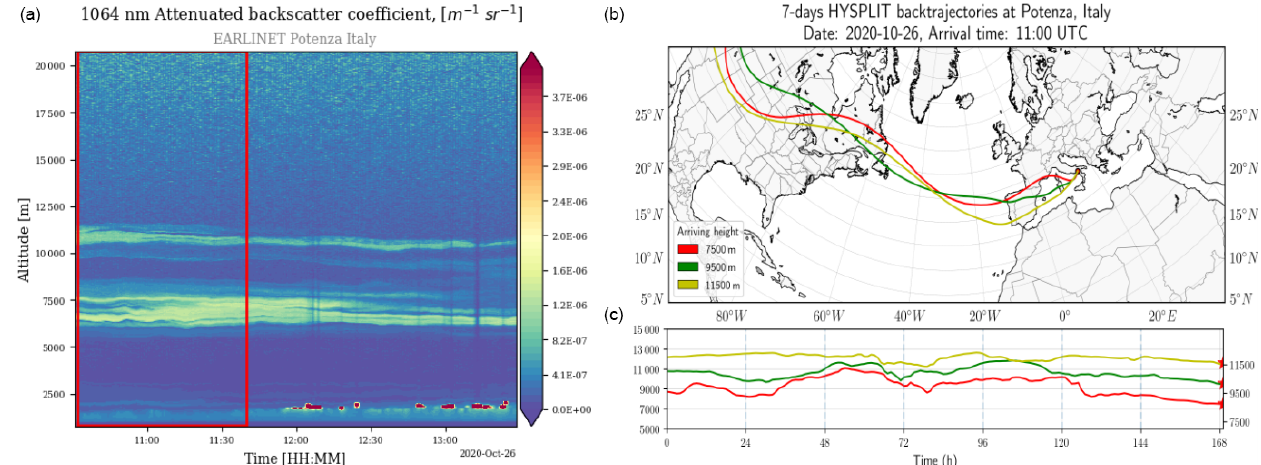
Figure 13. (a) Temporal evolution of the total attenuated backscatter signal from the MUSA lidar system at 1064nm showing the detection of the smoke cloud, and (b) 7d HYSPLIT back trajectories arriving at Potenza, Italy, on 26 October 2020 at